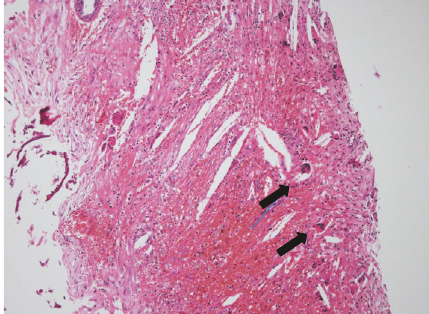
Figure 5: The pathological specimen showing a typical cholesterol granuloma. Granulation contains clefts of cholesterol crystals, giant cells, and infiltration of inflammation tissue (arrow). HE stain,